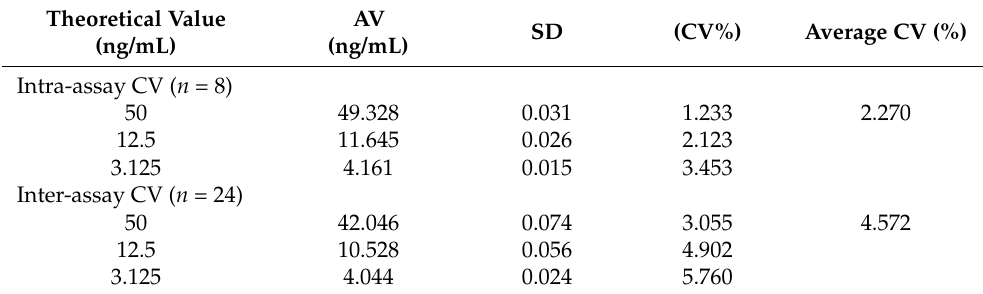
Table 5. Inter- and Intra-assay coefficients of variation of the established PAT/pat ELISA method.